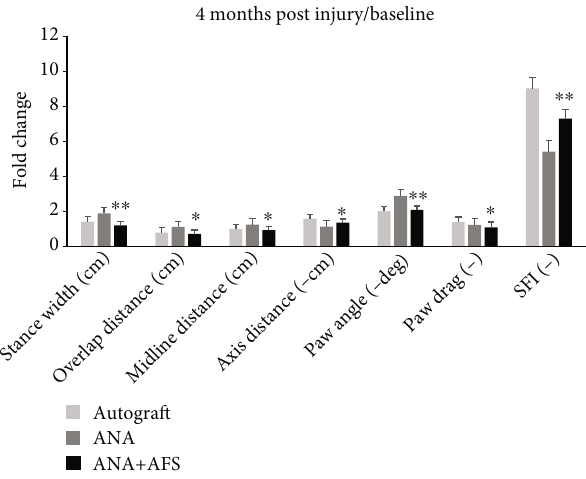
Figure 3: Gait indices of baseline and 4 months post nerve transection injury repaired by ANA plus AFS, ANA, and autograft group. Fold change ratio of 4 months post nerve transplantation to baseline indices demonstrated signi fi cant improved gait recovery in the ANA plus AFS compared to the ANA group alone. ∗ p < 0 : 05 ; ∗∗ p < 0 : 01